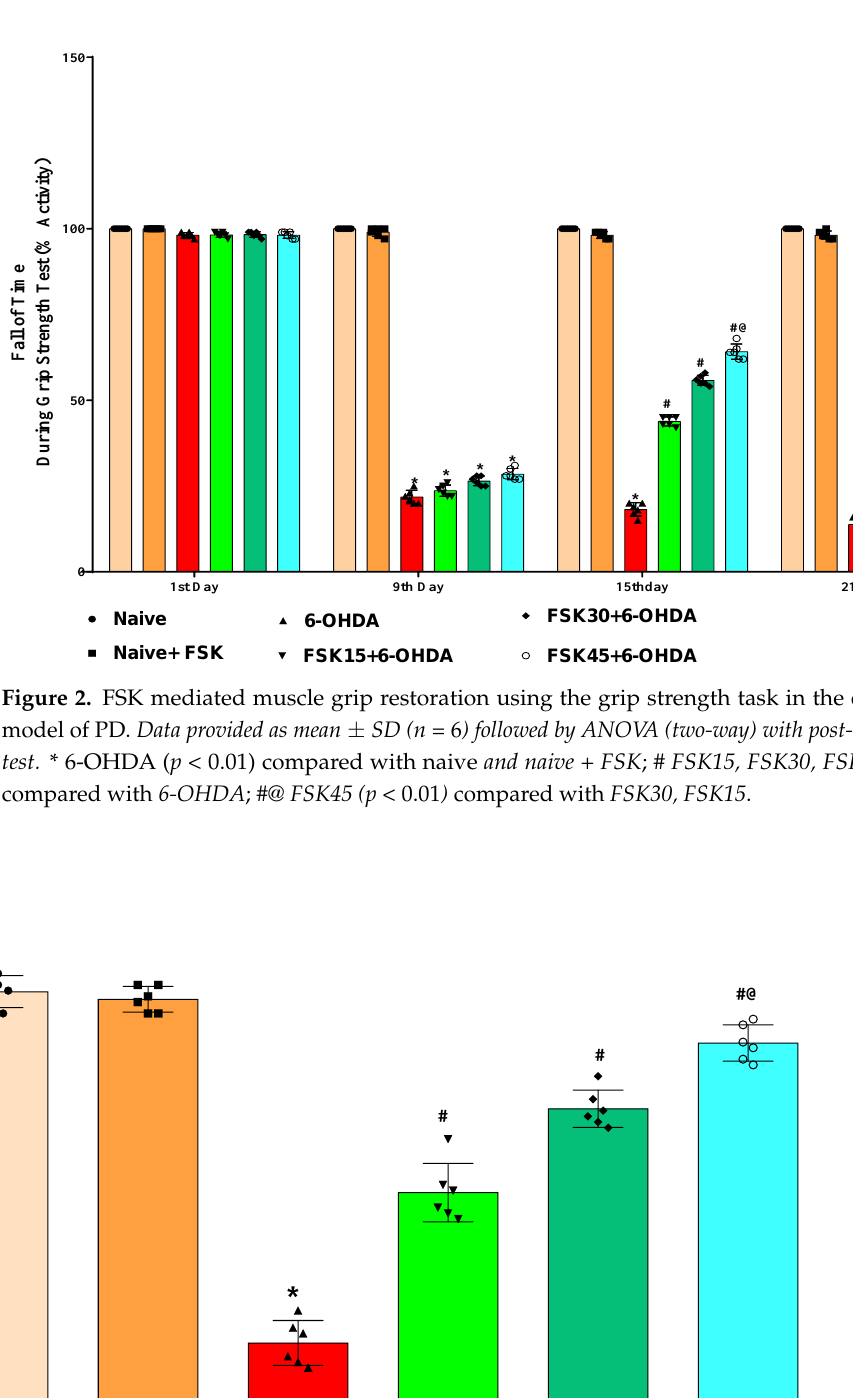
Figure 3. FSK improved memory retention using an elevated plus maze (EPM) in the experimental model of PD. Data provided as mean ± SD (n = 6) followed by ANOVA (one-way) with post-hoc Tukey’s test. * 6-OHDA ( p < 0.01) compared with naive and naive + FSK ; # FSK15, FSK30, FSK45 (p < 0.01) compared with 6-OHDA ; #@ FSK45 (p < 0.01) compared with FSK30, FSK15